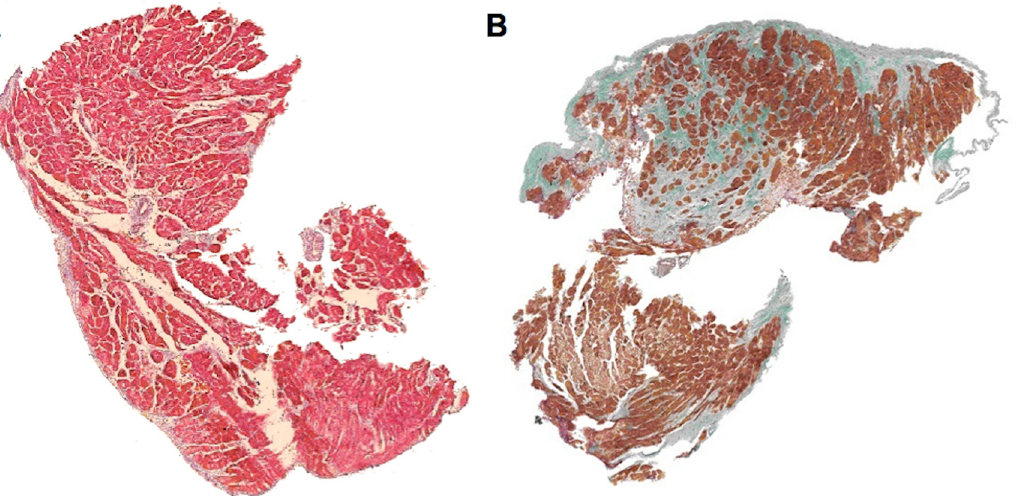
Fig 2. Left ventricular myocardial biopsies from HFpEF patients. Panel A shows a representative myocardial biopsy from a patient with a normal stroke volume (70ml) and a small extent of extracellular matrix (12%/mm 2 ). In contrast, panel B shows a representative myocardial biopsy from a patient with a lower stroke volume (51 ml) and a significant amount of extracellular matrix (57%/mm 2 ). Trichrome stain. Extracellular matrix stains blue-purple or